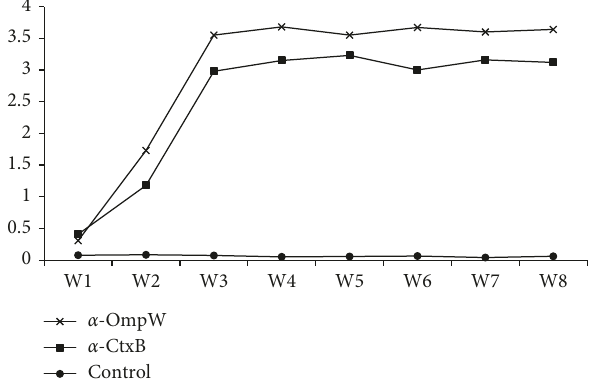
Figure 2: Changes in the specific IgY levels in the egg yolk after the last immunization in immunized and control